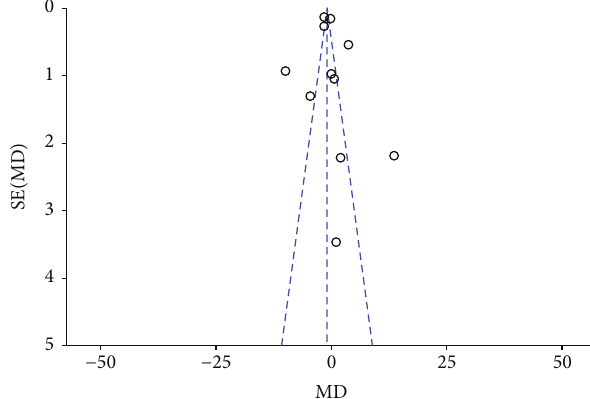
Figure 4: Funnel plot for meta-analysis of onset of sensory anesthesia. Table 3: Subgroup analysis of the study